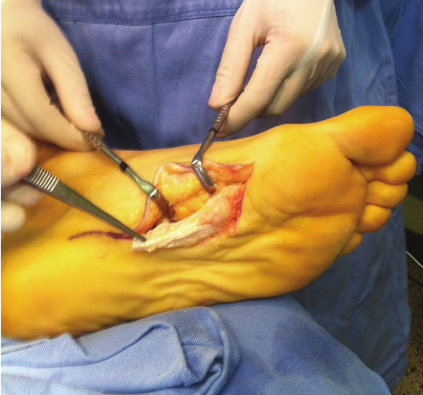
Figure 5: After isolating the plantar fascia, its proximal portion was transversely divided.